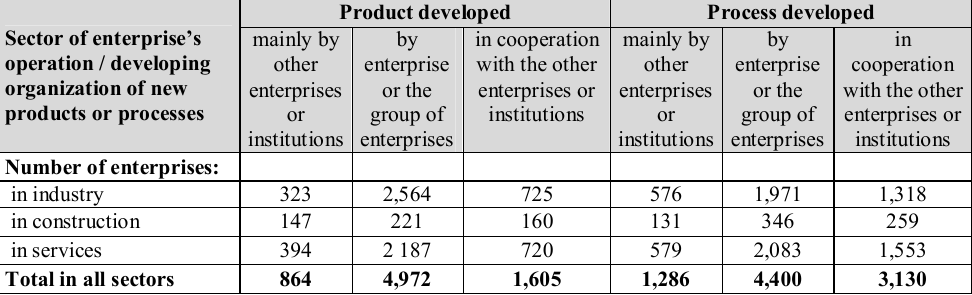
Table 6 - Product and process innovation according to the developing organization and the sector of its operation in Czech Republic Sector of enterprise’s operation /